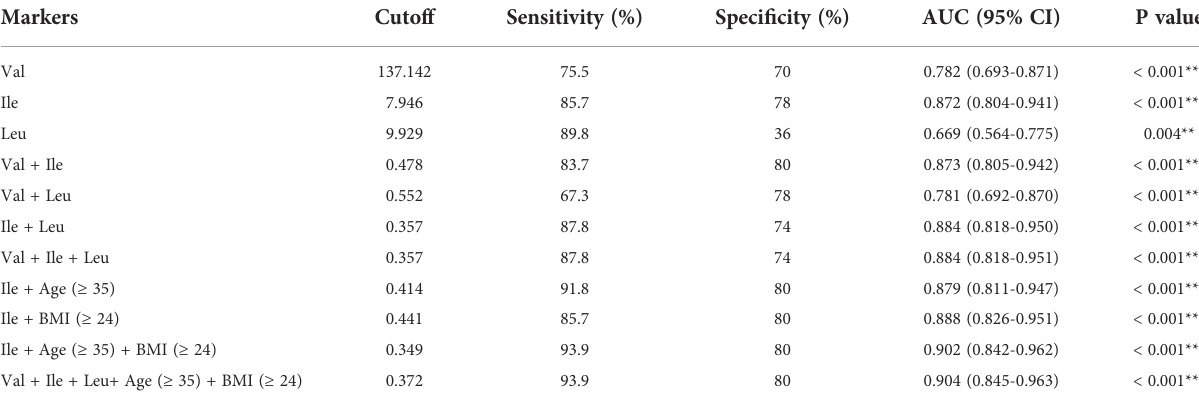
TABLE 5 The predictive value of BCAAs in gestational diabetes mellitus (GDM) at the fi rst trimester (8-12 weeks). Markers